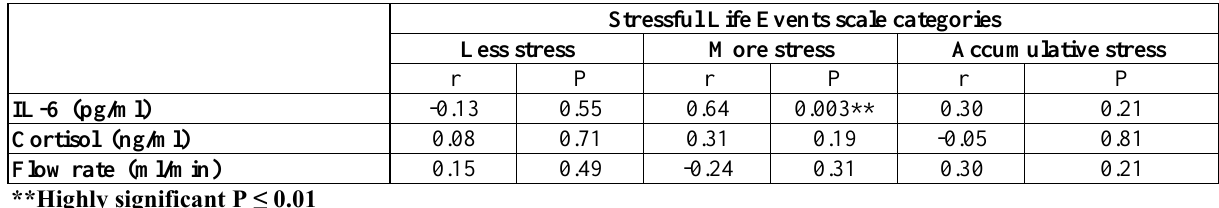
Table (6): Correlation coefficient between salivary Total protein and salivary constituents according to categories of Stressful Life Events scale